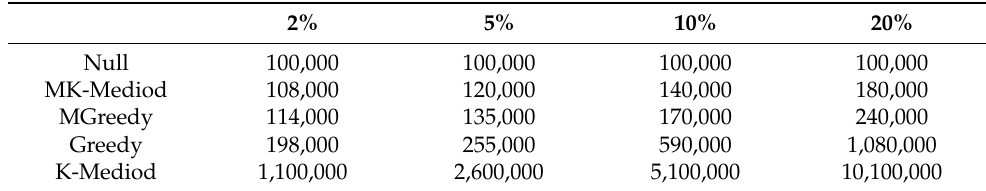
Table 2. Total storage load at different co-storage ratios.